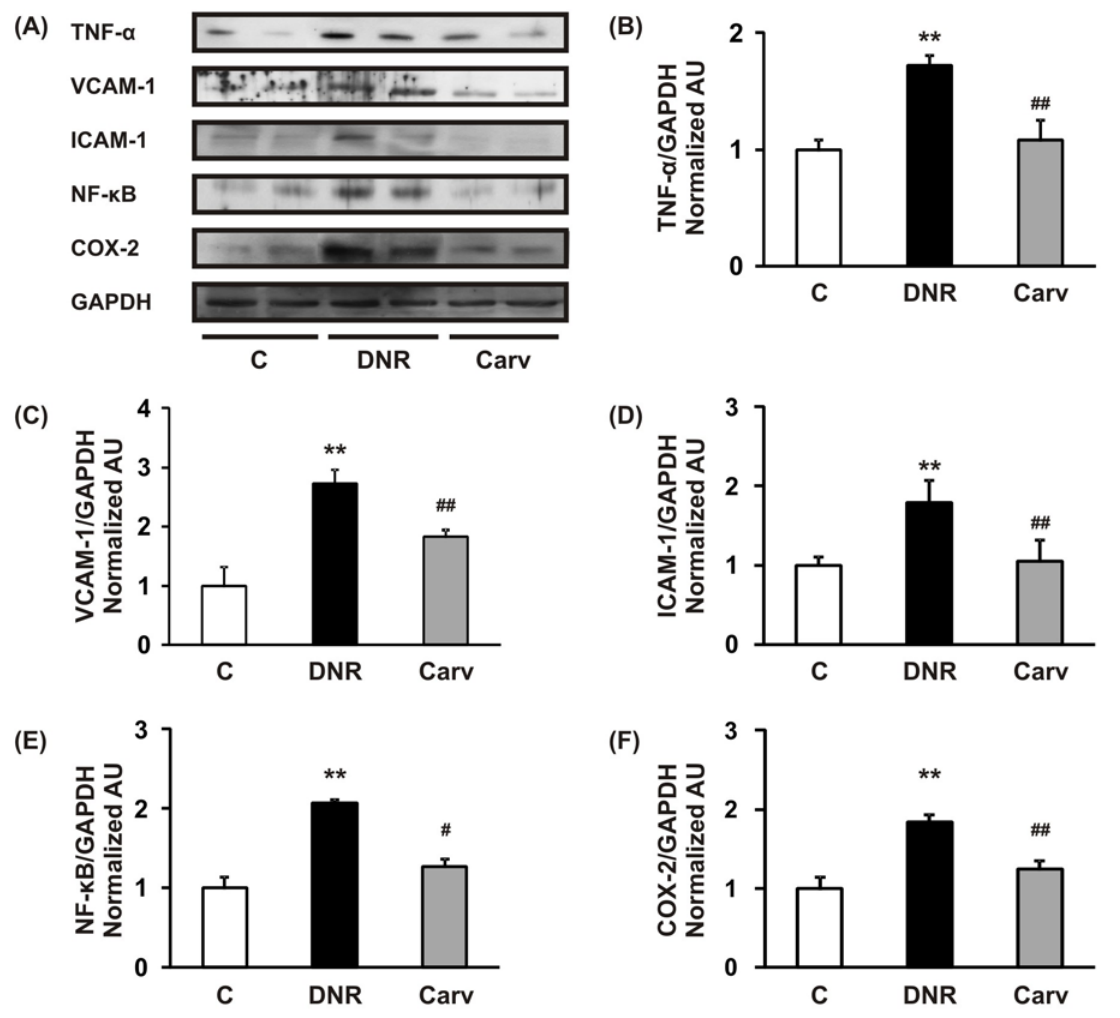
Figure 3. A, Western immunoblots of myocardial TNF- α , VCAM-1, ICAM-1, NF- κ B and COX-2 are showing two representative experiments out of four. All bands were normalized against GAPDH. B-F, Densitometric data of protein analysis. In B-F, the white, black and grey bars, respectively, represent the control (age-matched normal rats), DNR (DNR- treated rats administered with vehicle) and the Carv (DNR-treated rats administered with carvedilol (30 mg/kg/day)) group. Each bar represents mean ± S.E.M. ** p < 0.01 vs. group Control; # p < 0.05 and ## p < 0.01 vs. group